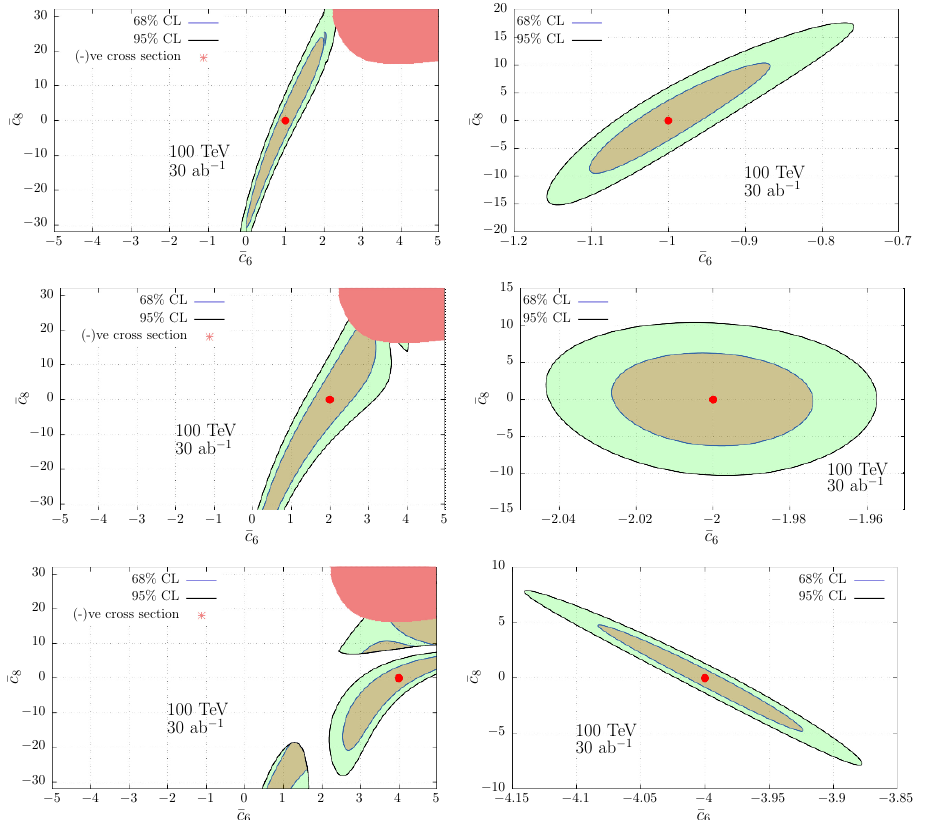
= (cid:6) 1, (cid:6) 2, 6